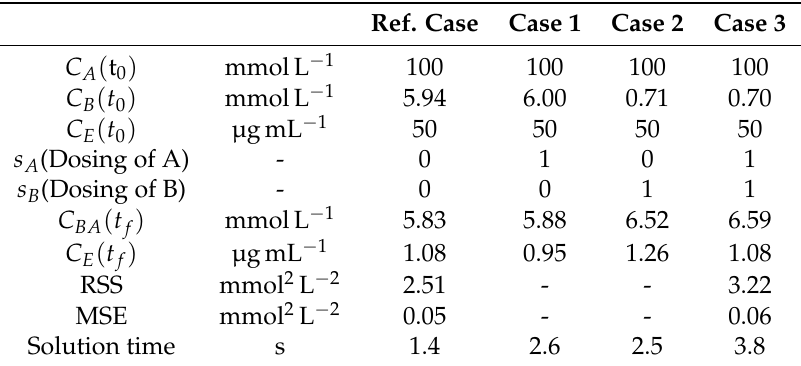
Table 1. Summary of the optimization results: initial concentrations C i ( t 0 ) , final concentrations C i ( t f ) , solution time for the reference case and the three process intensification scenarios, as well as the residual sum of squares (RSS) and mean squared error (MSE) for the experimental validations.